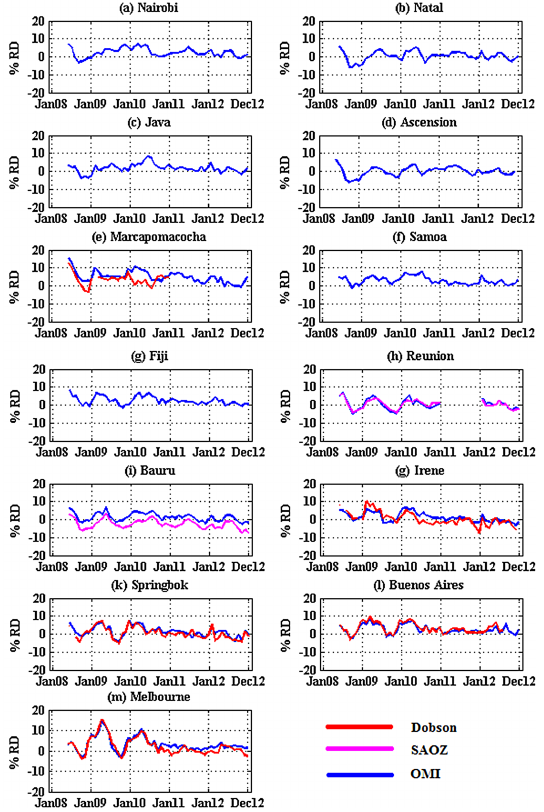
Figure 4. Monthly relative differences (% RD) of TCO observed from June 2008 to December 2012 between IASI and the other instruments (OMI (13 stations), Dobson (five stations) and SAOZ (two